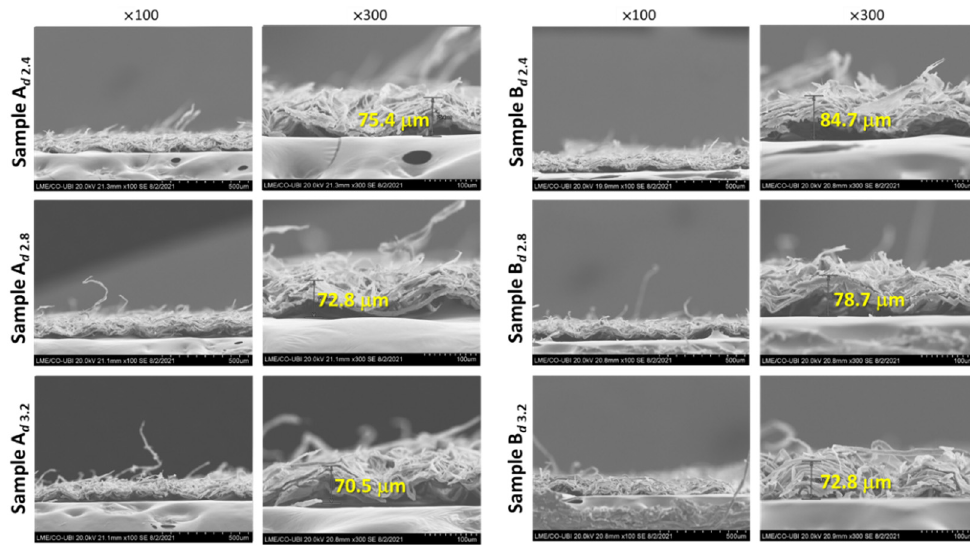
Figure 6 . SEM images of samples A and B at two magnifications (×100 and ×300), at pressures of 2.4, 2.8, and 3.2 bar. The measurements presented in yellow corresponds to the height of the crepe wave. The water dynamic spreading area evolutions measured on the non-compressed base tissue papers and those compressed at the optimal pressure of 2.8 bar are presented in Figures 7 and 8, respectively, for the samples A and B.